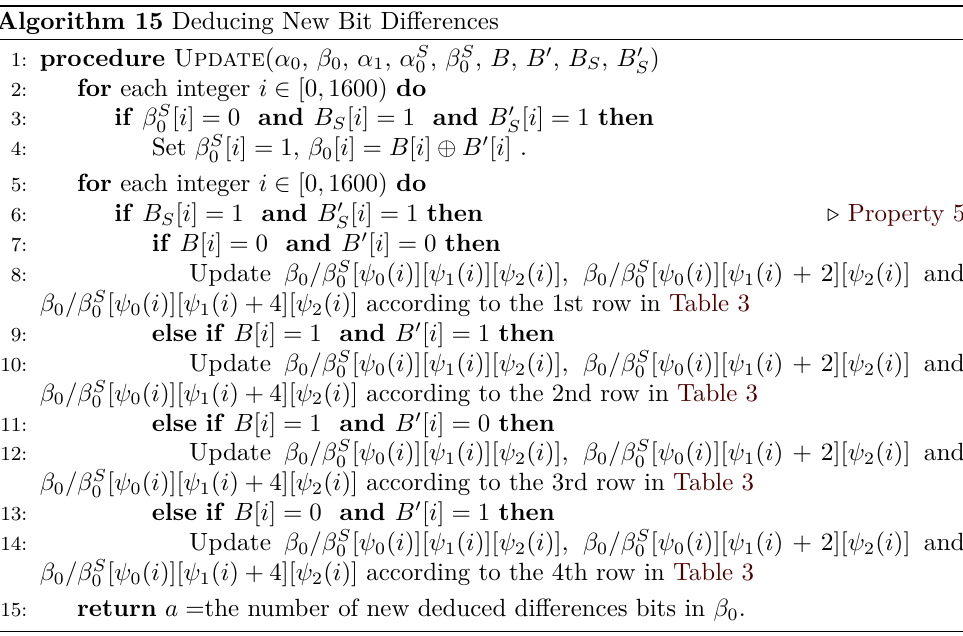
Algorithm 15 Deducing New Bit